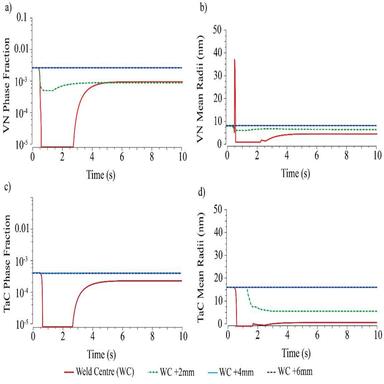
The predicted evolution of MX-type precipitates in the weld zone during LKW.